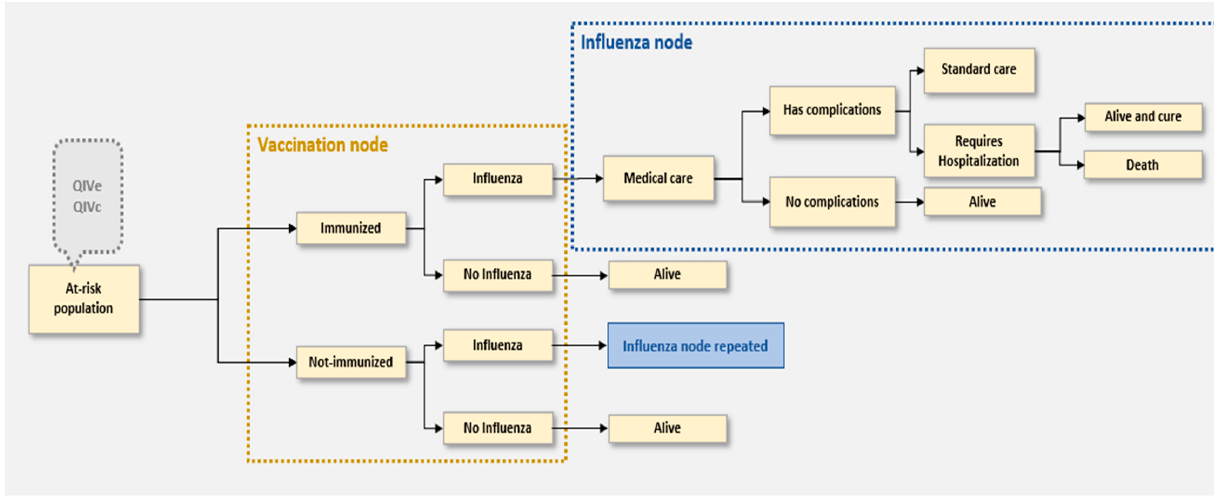
Figure 1. Decision tree model structure.